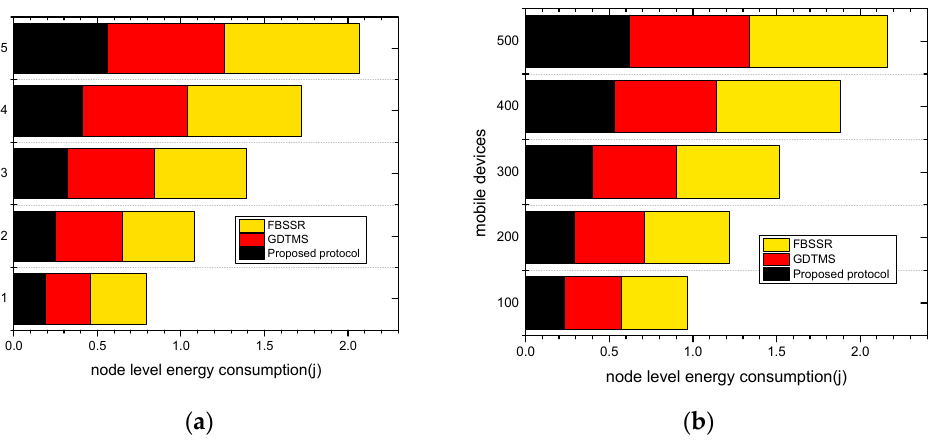
Figure 9. ( a ) Energy consumption with message generation interval. ( b ) Node level energy con-